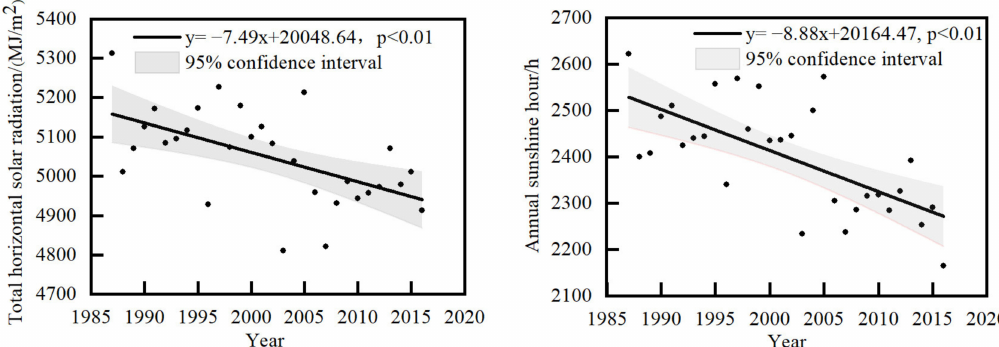
Figure 6. The variation trend of total horizontal solar radiation and annual sunshine hours in Shanxi